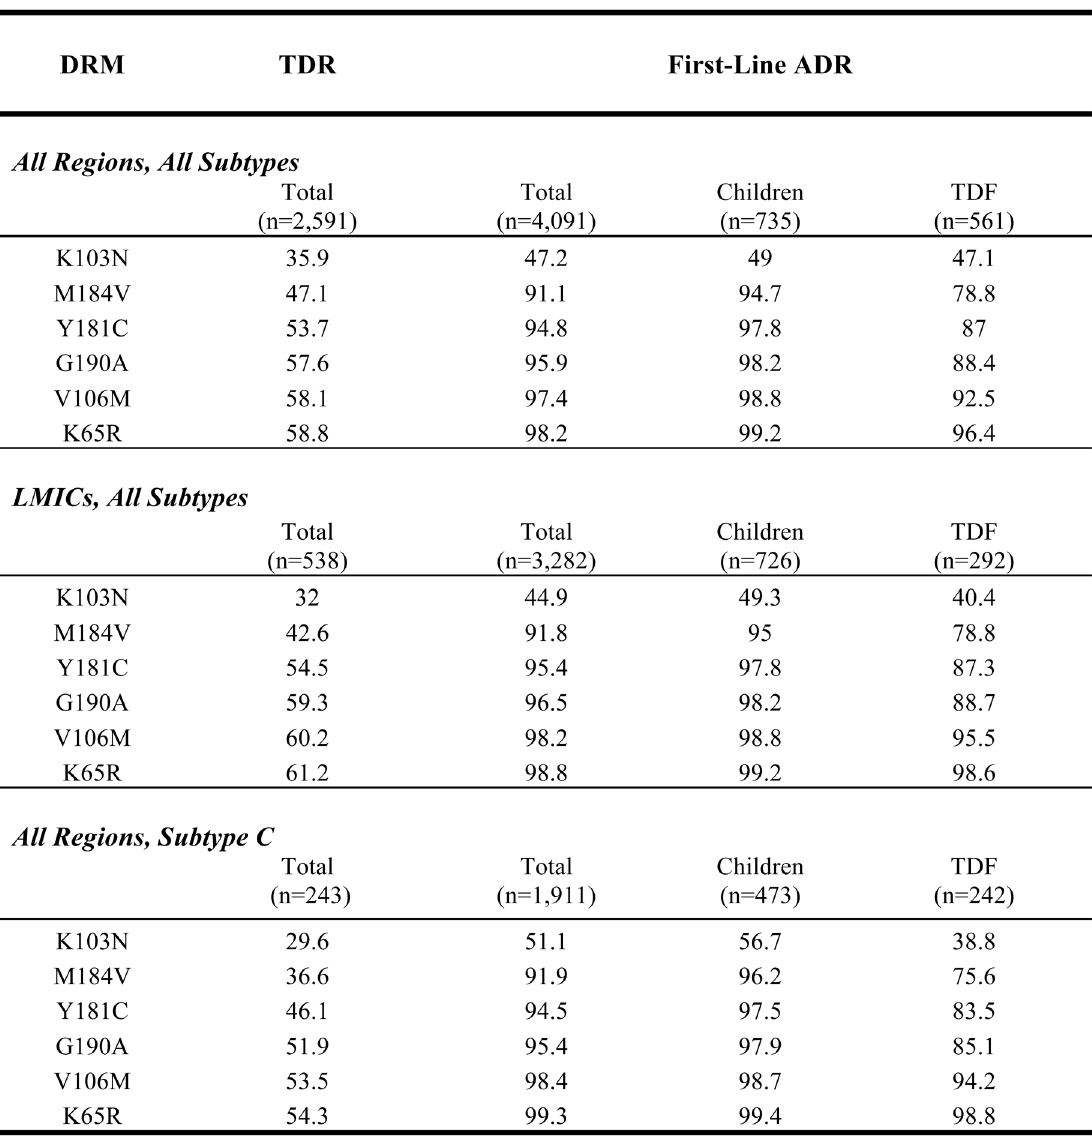
Fig 3. Sensitivity of Six Tier 1 RTI resistance mutations for detecting transmitted or acquired drug resistance. Cumulative prevalence or sensitivity of the Six Tier 1 RT inhibitor (RTI) drug-resistance mutations (DRMs) for detecting transmitted or acquired drug resistance in viruses from individuals with intermediate or high-level NRTI or NNRTI resistance is shown. Transmitted drug resistance (TDR) and acquired drug resistance (ADR) were defined as being associated with (cid:1) intermediate NRTI or NNRTI resistance. Major NRTI-associated DRMs (HIVDB score (cid:1) 30) included K65R, D67 deletion, T69 insertion, K70R, L74V/I, Y115F, Q151M, M184I/V, and T215F/Y. Major NNRTI-associated DRMs (HIVDB score (cid:1) 60) included: L100I, K101P, K103N/S, V106A/M, Y181C/I/V, Y188L/H/C, G190A/S/E/Q, and M230L. Abbreviations: LMICs (Low- and Middle-Income Countries), TDF